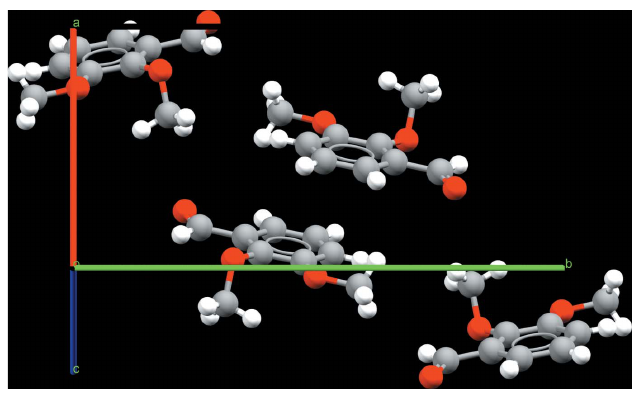
Figure 5 Crystal structure of 2,3-DMBz showing the orientation of the methoxy groups. One of the methoxy groups lies in the plane of the aromatic ring. The second methoxy group points towards the aldehyde group of a neighbouring 2,3-DMBz molecule.